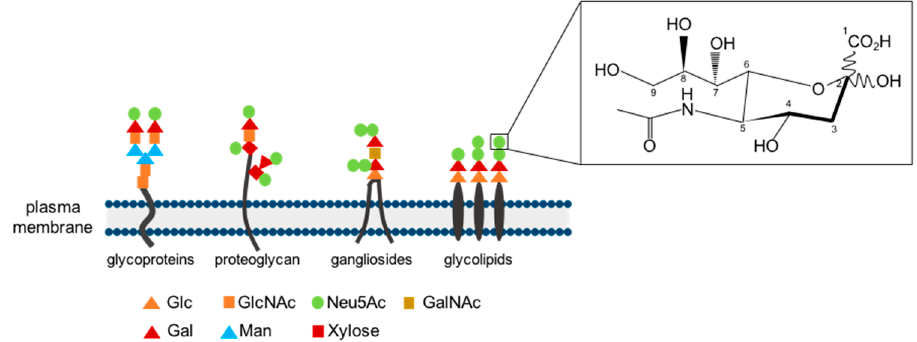
Figure 1. Structure and position of sialic acids: Sialic acids positioned at the end of sugar chains of glycoproteins, proteoglycans and glycolipids. Abbreviations: Gal, galactose; GalNAc, N-acetylglucosamine; Glc, glucose; GlcNAc, N-acetlyglucosamine; Man, mannose; Neu5Ac, N-acetylneuraminic acid. Figure adapted from Klaus et al., 2020.